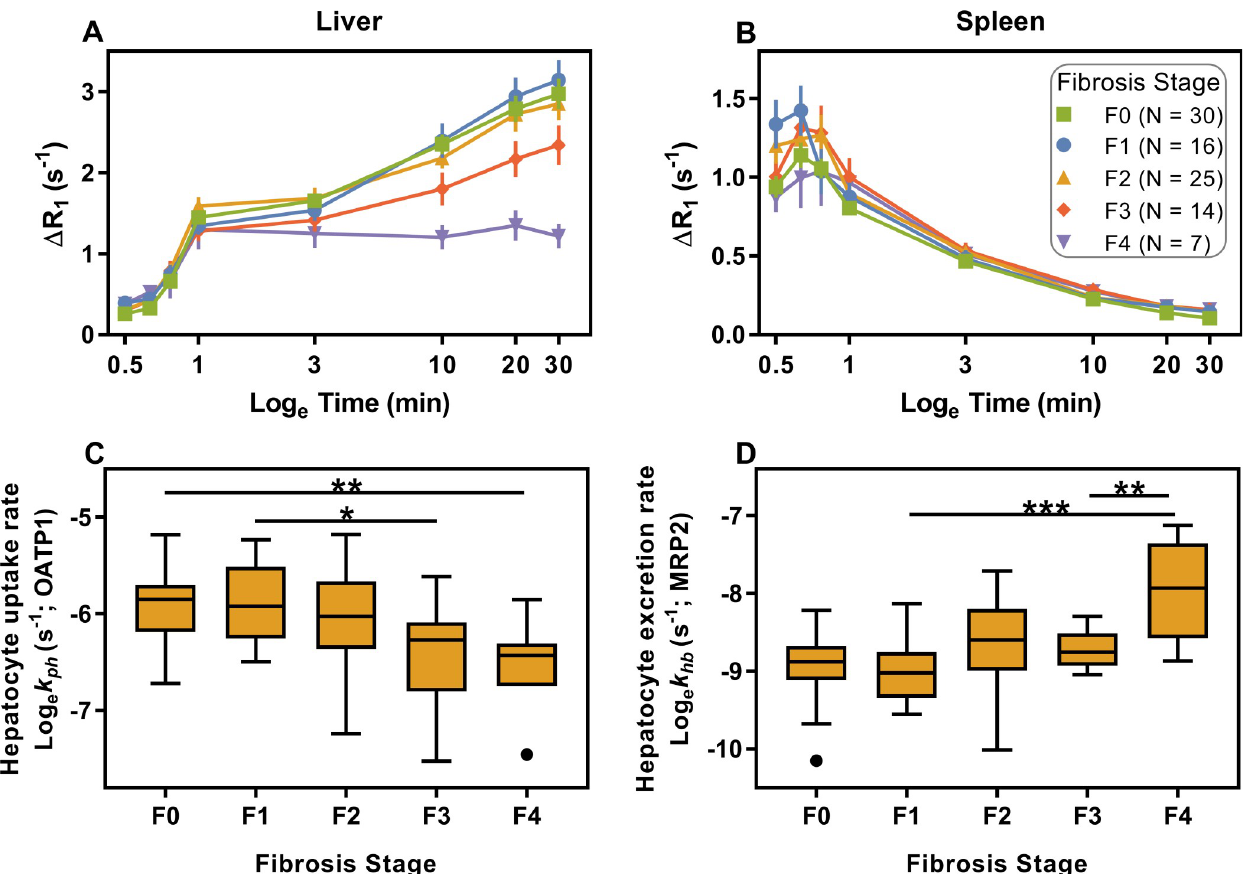
Fig 4. Effects of fibrosis on hepatic function. Liver ( A ) and spleen ( B ) time series showing average induced change in R 1 relaxation rate ( Δ R 1 ) in patients with different levels of fibrosis. Error bars indicate the standard error of the mean. In ( C, D ), liver function parameters are shown for each level of fibrosis. Horizontal lines indicate significant differences (ANOVA, Tukey’s post-test: � < 0.05; �� < 0.01; ��� < 0.001).